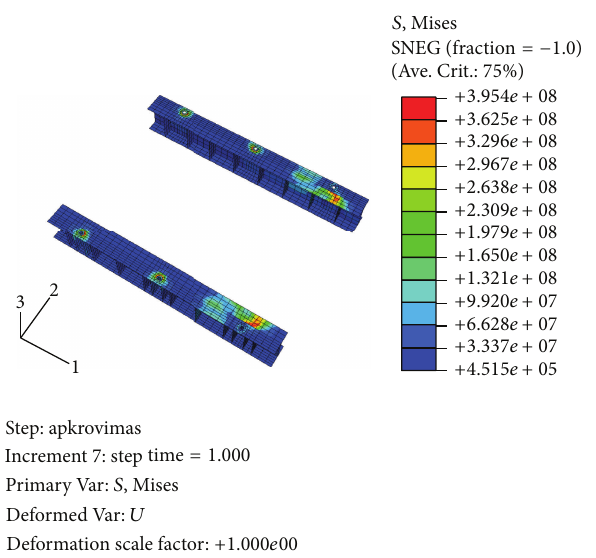
Figure 12: The von Mises stress (Pa) distribution in the I-beam in level 0.00 m.